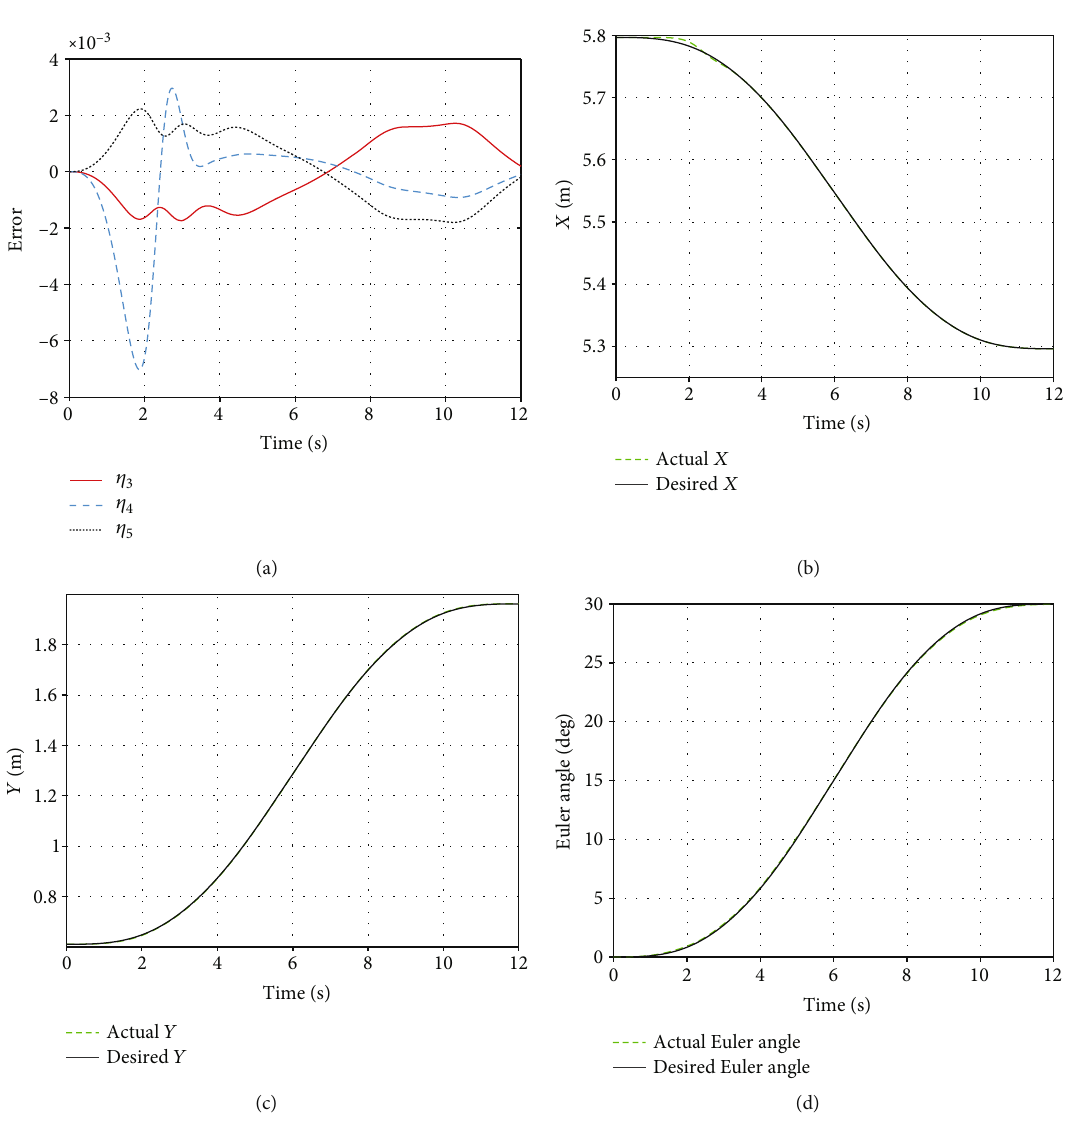
Figure 3: Error and pose components in the tracking